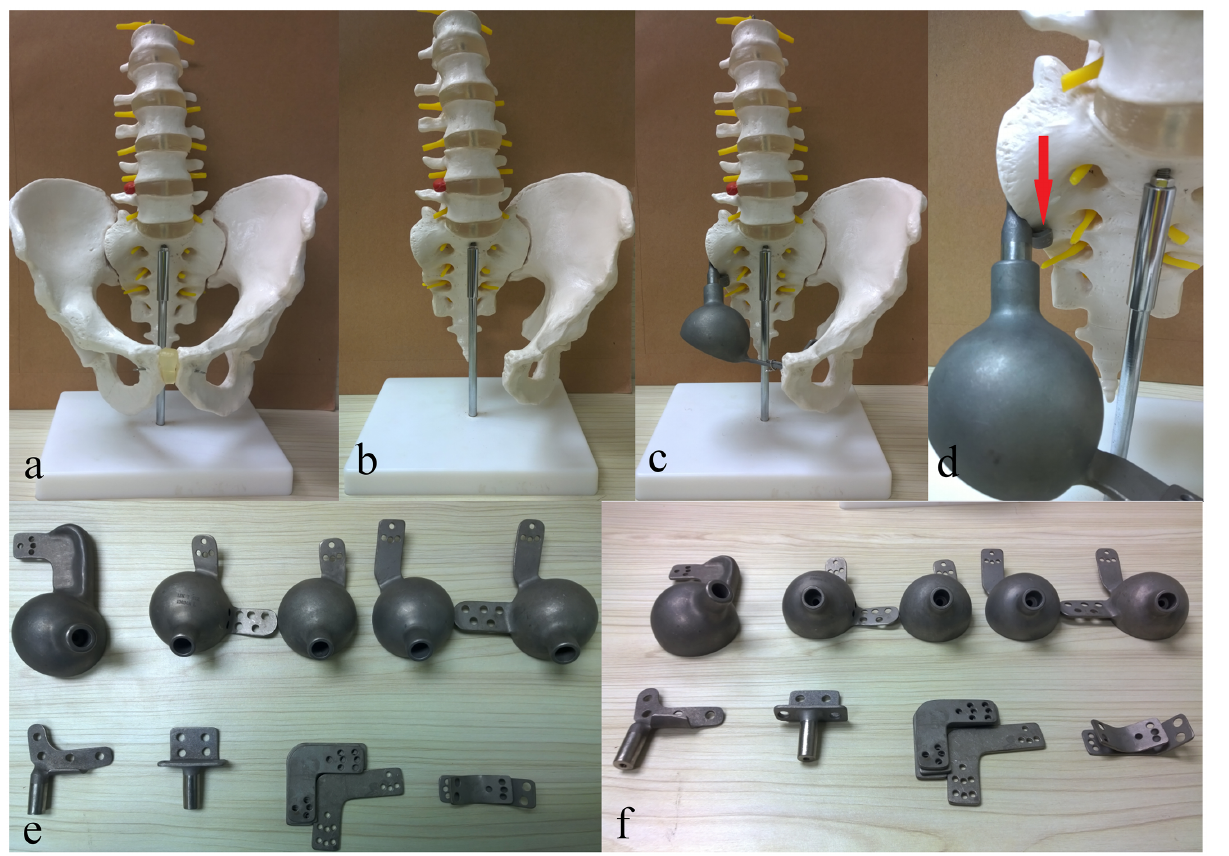
Fig 1. The modular hemipelvic endoprosthesis used in our study. (a) Preoperative model of pelvis. (b) Postoperative model after resection of tumor in which osteotomy was performed to sacroiliac joint and pubic symphysis. (c) Postoperative model reconstructed with modular hemipelvic endoprosthesis. (d) The sacral hook (indicated by a red arrow) transforming tearing forces of the sacral connecting screws into compressing stress. (e) and (f) The disassembled components of our modular hemipelvic